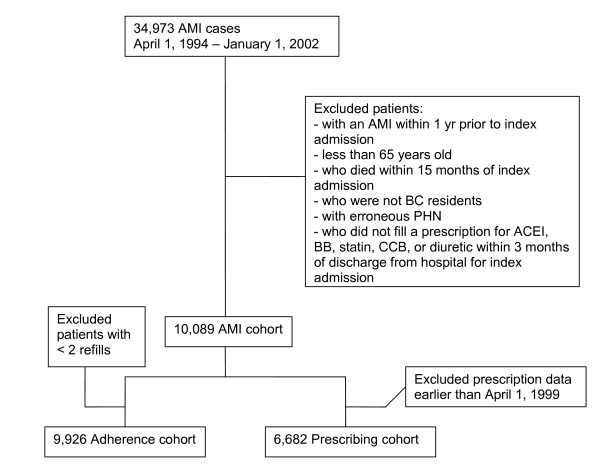
Patient Flow Diagram. ACEI = angiotensin converting enzyme inhibitor, AMI = acute myocardial infarction, BB = beta-blocker, BC = British Columbia, CCB = calcium channel blocker, PHN = personal health number, statin = HMG-CoA reductase inhibitor.